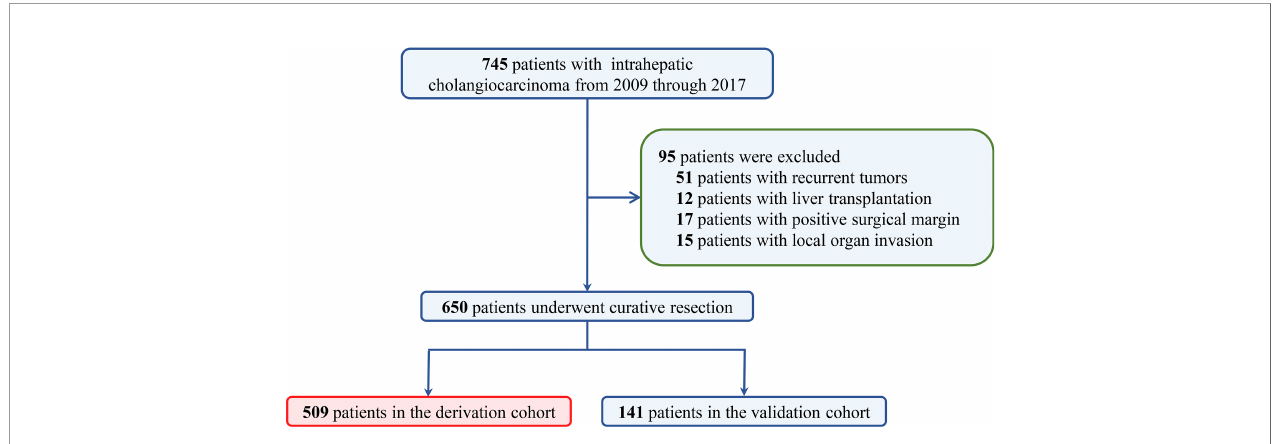
FIGURE 1 | The selection process of ICC patients in the fi nal analysis. ICC, intrahepatic